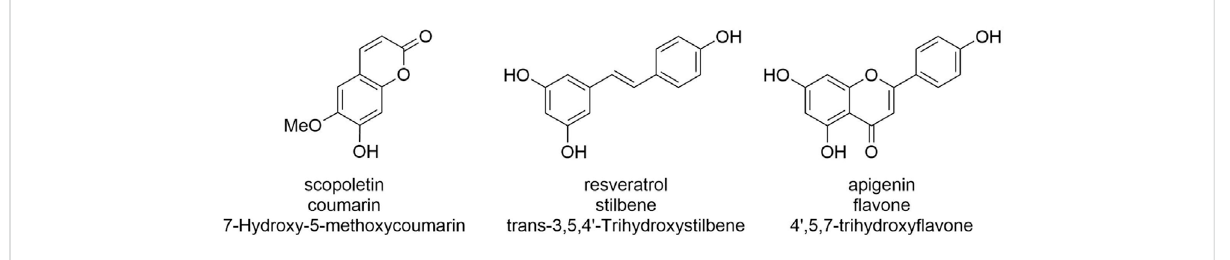
FIGURE 1 Acceptors assessed in this study. Note that while only a single glucosylation product is possible for scopoletin, several could be — and are — formedbyGT1enzymesforresveratrolandapigenin.Giventhatdifferentproductsorproductmixturesareobservedforthevariousenzymatic: substrate pairs, the displayed analytical yields relate to acceptor consumption and are cross-validated by analyzing the sum of the peak areas observed for products.